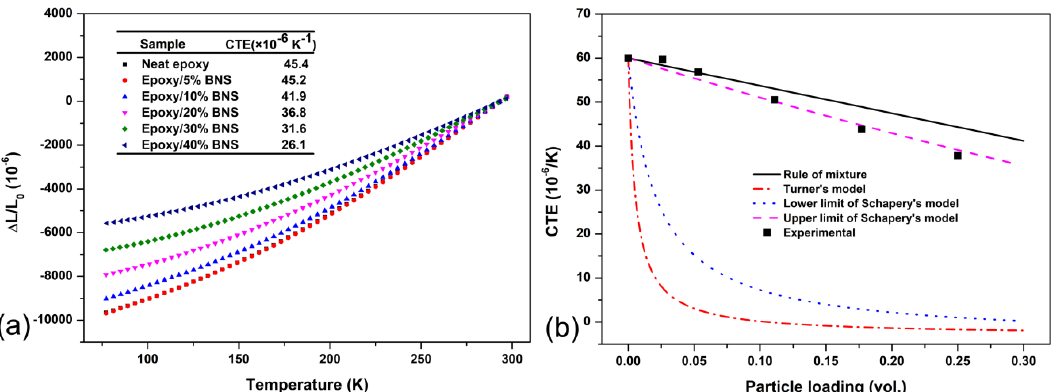
Figure 5. ( a ) Linear thermal expansion curves of epoxy / BNS composites in temperature range of 77–298 K at a heating rate of 5 Kmin − 1 ; ( b ) Measured CTEs and calculated CTEs by analytical models.